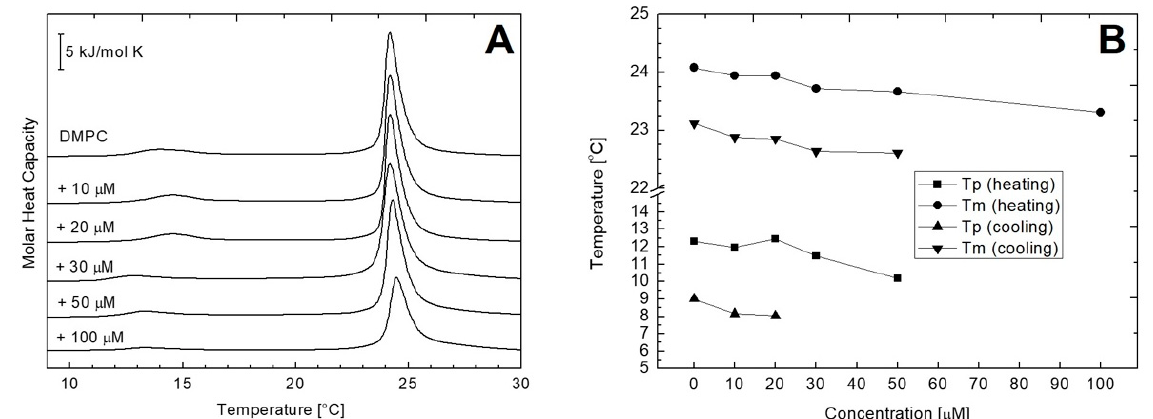
Int. J. Mol. Sci. 2021 , 22 , x FOR PEER REVIEW 8 of 19